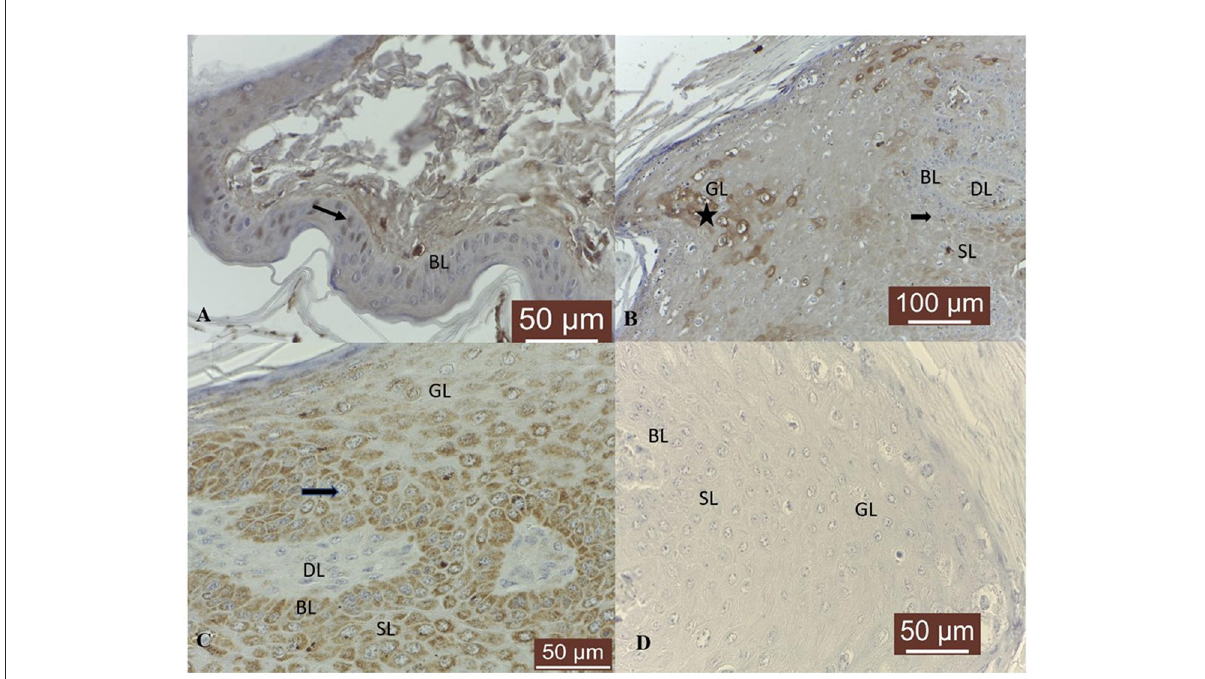
FIGURE3 MMP-7 immunostaining in bovine normal skin and fibropapillomas: (A) Normal skin: MMP-7 perinuclear and nuclear immunoreactivity (black arrow) predominantly in basal cell layer (BL); 40 X. (B) Fibropapillomas: MMP-7 appeared as a finely granular cytoplasmatic (black arrow) and perinuclear staining in keratinocytes from basal (BL), spinosum (SL) and granular (GL) epithelial layers and in 20–30% of fibroblast cells from dermal layer (DL), while scattered keratinocytes from granular layer (GL) showed a strong immunoreactivity (black star); 20 X. (C) A detailed MMP-7 strong perinuclear (black arrow) immunosignaling confined to BL, SL and GL epithelial cells; 40 X. (D) Negative control: fibropapilloma with the first antibody anti-MMP-7 omitted and incubated with secondary antibody did not stain; 40